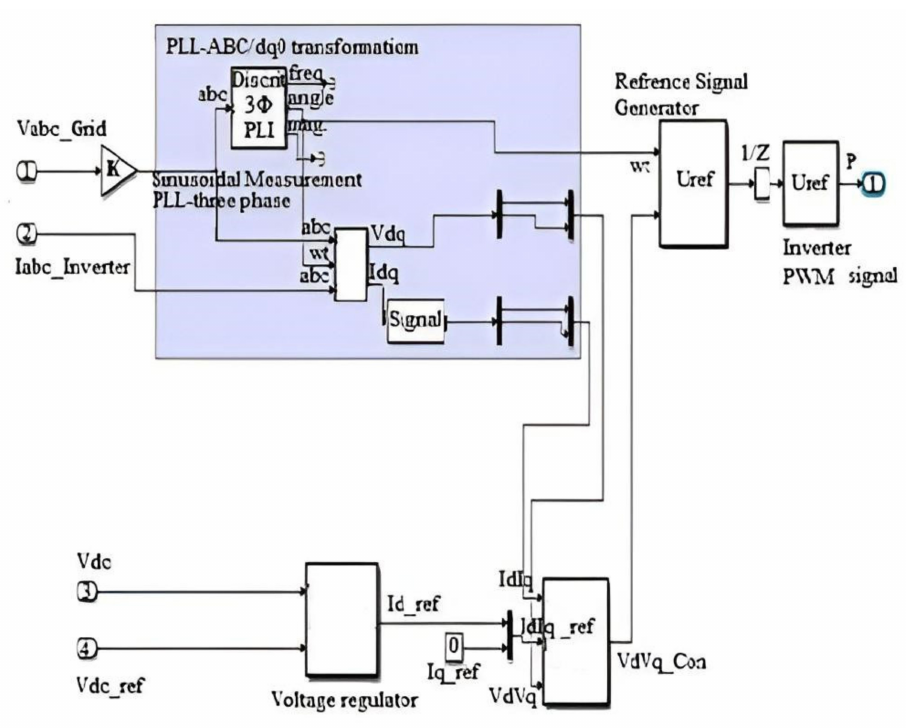
Figure 13. Total inverter control building